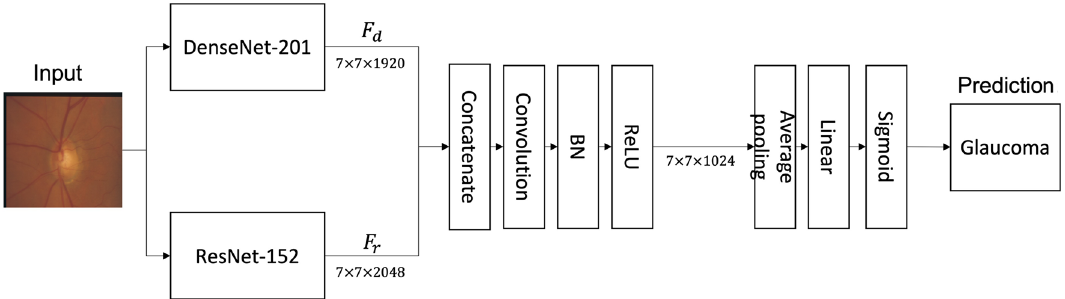
Figure 2. The architecture of the proposed